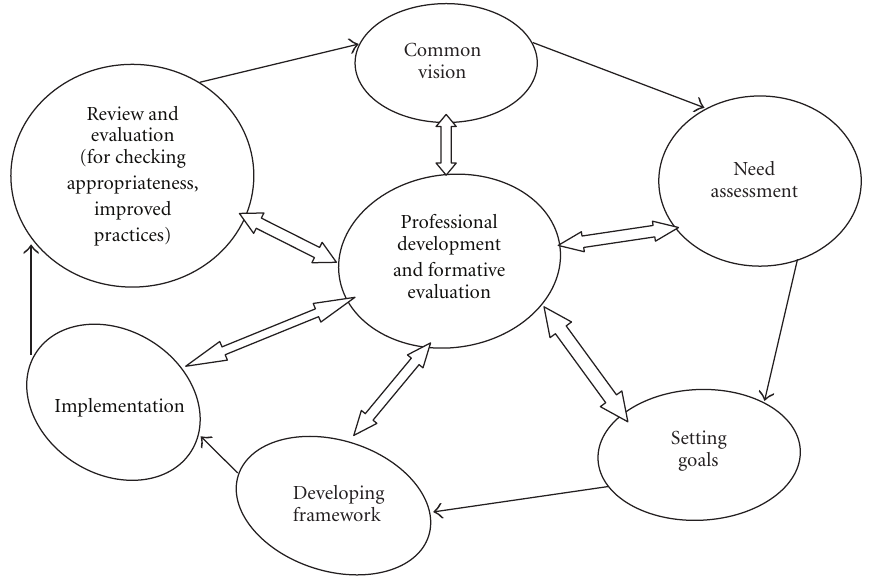
Figure 1: A model suggested for future deliberation of PDP in Ethiopian